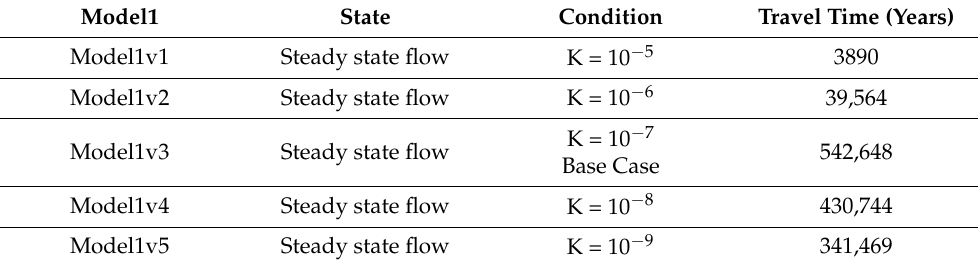
Table 5. Sensitivity analysis for the Mountainous